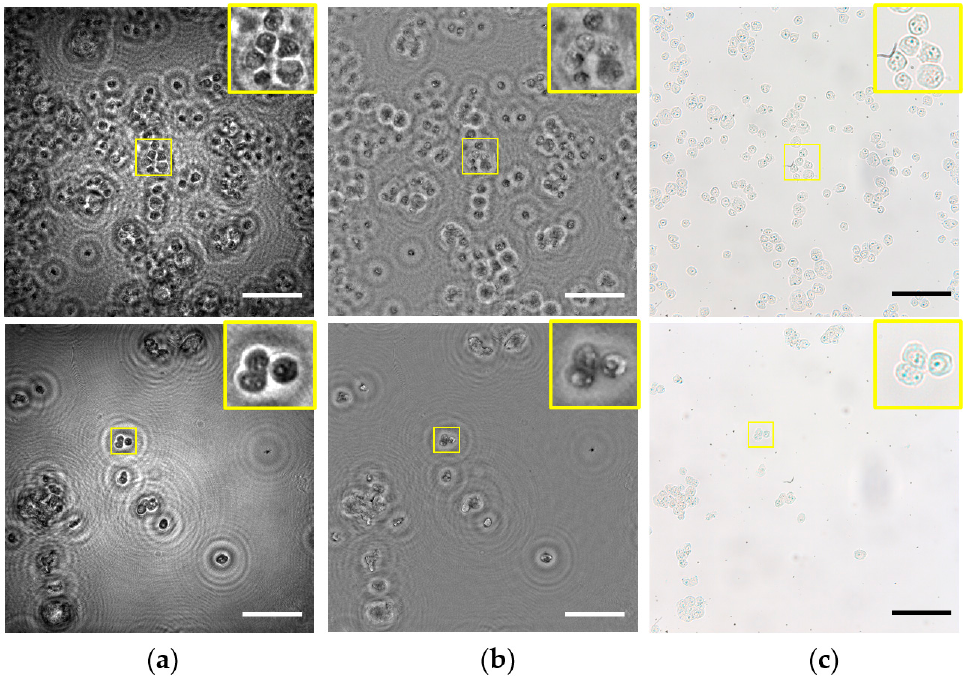
Figure 9. Inspection of different static and unlabeled biosamples. Rows 1–2 include the images for PC-3 and LnCaP prostate cancer cell lines, respectively. ( a ) Intensity and ( b ) phase images retrieved using the proposed lensless microscope. ( c ) 20X intensity images recorded using a bright field microscope. Scale bars are 100 μ m.